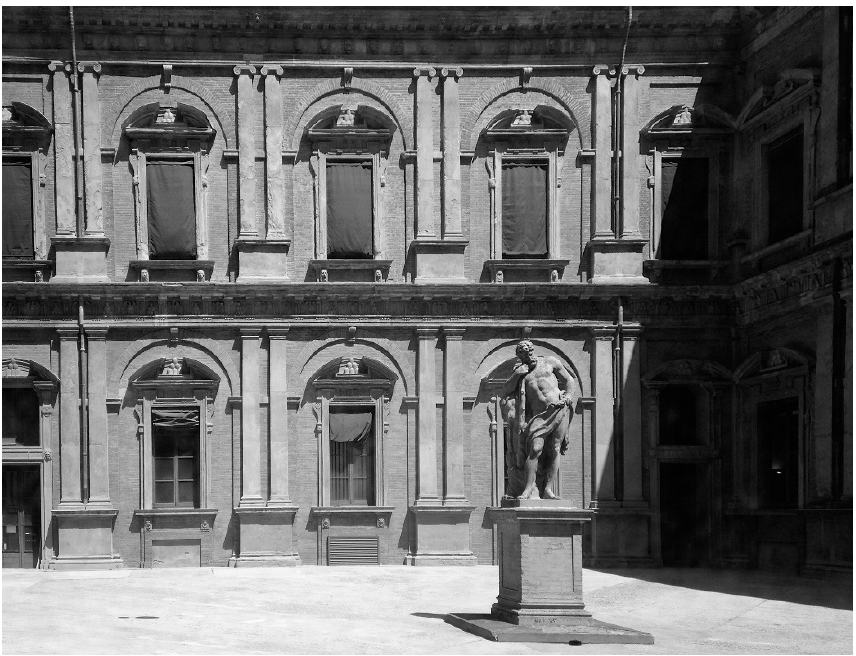
Figure 3. Internal view of Hercules’ courtyard (Ferretti, Indio).